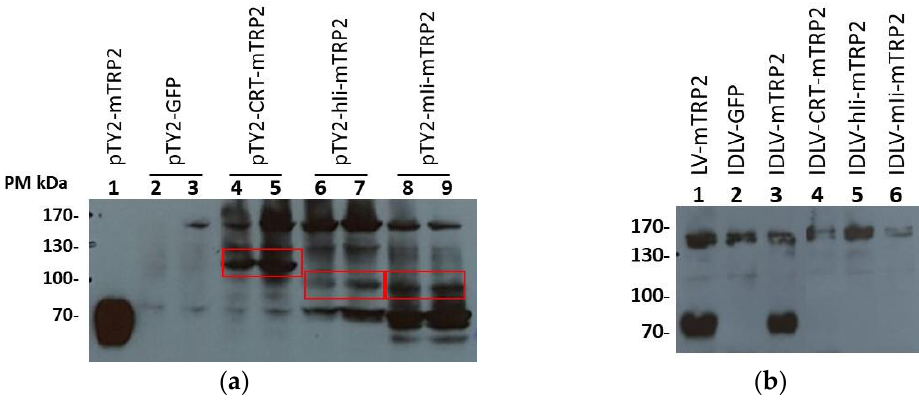
Figure 5. Expression of different TRP2 fusion proteins by Western blot. ( a ) Cell lysates of Lenti-X transfected with transfer vector expressing either mTRP2 (predicted size 70 kDa) or mTRP2 fused with CRT (Calreticulin, predicted size 123 kDa), hIi (human invariant chain, predicted size 109 kDa), or mIi (murine invariant chain, predicted size 106 kDa). Lenti-X cells transfected with mTRP2 wild type (5 × 10 4 cells, lane 1) and GFP transfer vectors (lanes 2 and 3) were used as positive and negative control, respectively. The assay was performed using 1.6 × 10 5 (lane 2–4–6–8) or 3.2 × 10 5 cells (lane 3–5–7–9). Red boxes indicate the band with the correct molecular weight. ( b ) Detection of mTRP2 in viral vector preparations. 1.5 × 10 6 RT units of LV-mTRP2 (lane 1), IDLV-GFP (lane 2), IDLV-mTRP2 (lane 3), IDLV-CRT-mTRP2 (lane 4), IDLV-hIi-mTRP2 (lane 5), IDLV-mIi-mTRP2 (lane 6) were analyzed.